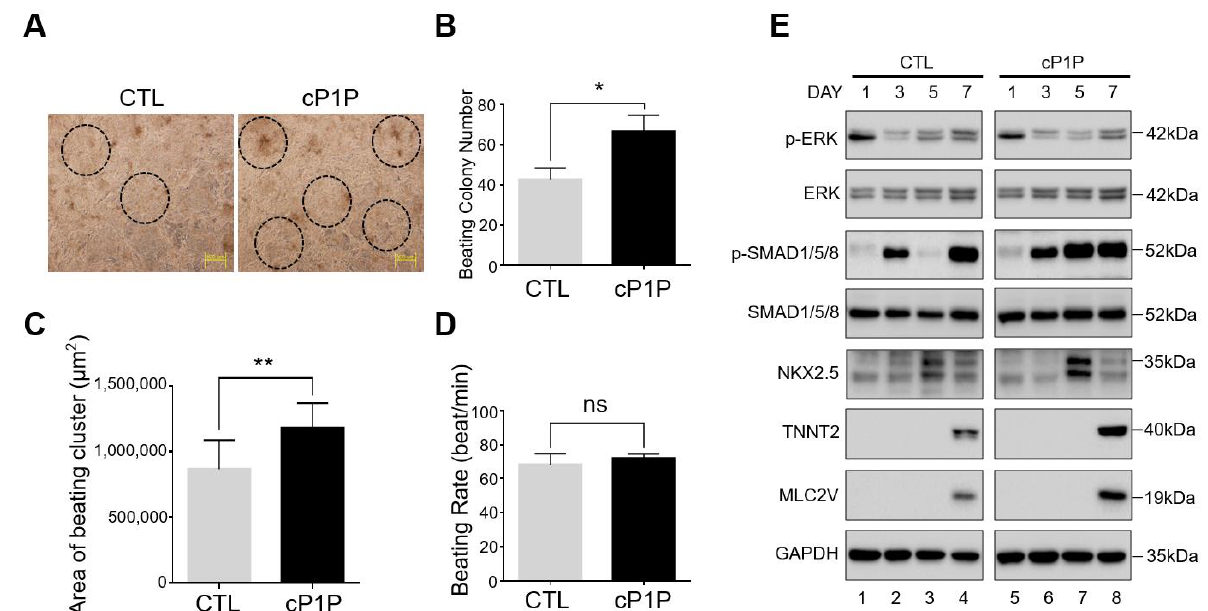
Figure 2. Bioactive lipid cP1P augments beating colony number and contracting area by activating SMAD signaling in human embryonic stem cells (hESC)-derived cardiomyocytes. ( A ) Representative image of the number of beating cardiomyocytes in the control (DMSO-treated) and cP1P-treated groups at day 6. Scale bar = 500 μm. ( B ) Cell number measurements of beating cardiomyocytes. hESCs were seeded into 12-well plates (7.5 × 10 4 cells/well), treated with DMSO (control) or cP1P as indicated, and induced to differentiate for 8 days. Data are presented as the means ± SDs of three independent experiments ( n = 3, * p < 0.05). ( C ) Areas of contraction of the beating clusters obtained from the control or cP1P groups at day 8 were calculated by ImageJ software using the captured images. Contracting areas were individually marked using ImageJ tools and a calibration of 0.46 pixels/μm was used to measure the area. Data are presented as the means ± SDs ( n = 11, ** p < 0.01). ( D ) Beating rates for the control and cP1P groups were measured as beats/min. Data are presented as the means ± SDs ( n = 3, ns = non-significant). ( E ) The expression levels of p-ERK, p-SMAD 1/5/8, total ERK, and SMAD 1/5/8 were analyzed along with the expression levels of cardiogenic transcriptional factors NKX2.5, TNNT2, and MLC2V by Western blot during CM differentiation in DMSO-treated control and cP1P-treated CMs at the indicated time points.